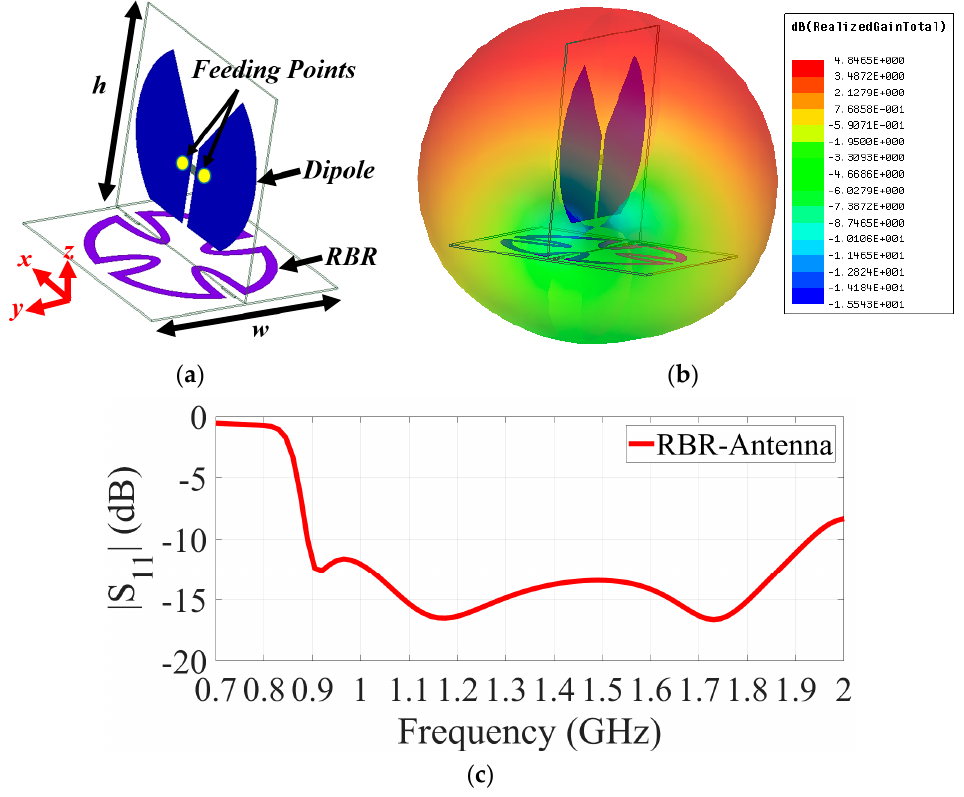
Figure 2. ( a ) Utilized RBR antenna [39] w = h = 100 mm. ( b ) Three-dimensional radiation pattern of the RBR antenna at sample frequency of 1 GHz and ( c ) its |S 11 | plot.